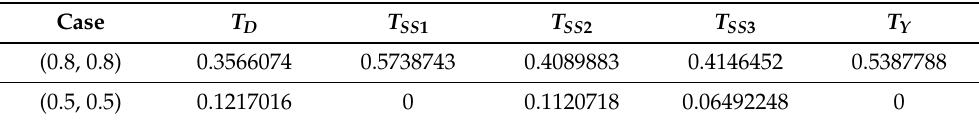
Table 2. Computation of different t-norms with andness α =